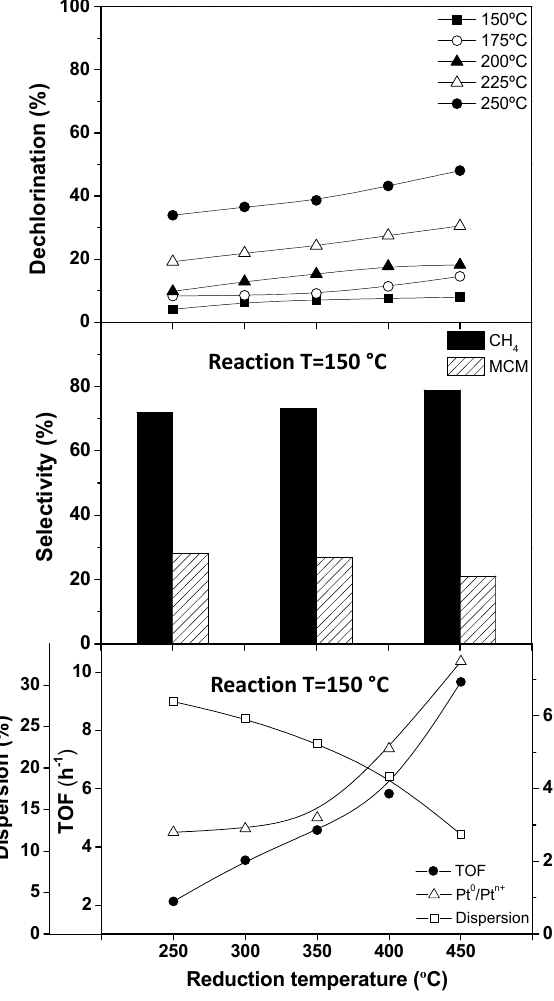
◦ C reaction temperatures, at 0.6 kg